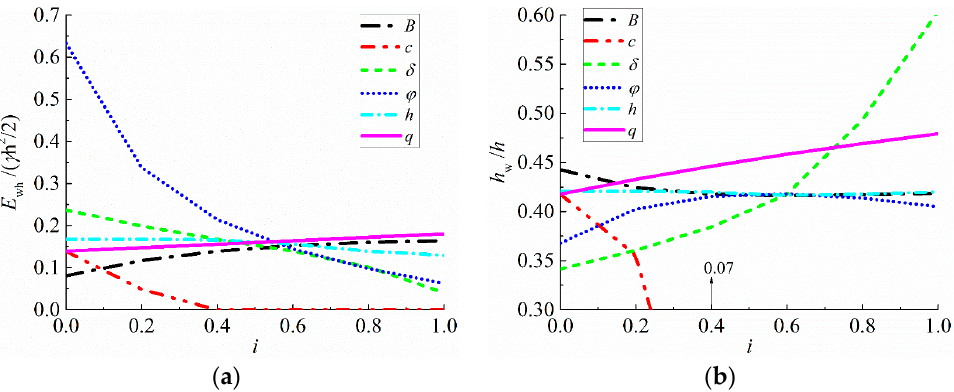
Figure 15. Comparison of each parameters’ effects after standardization on ( a ) the standard resultant force and ( b ) its standard action point.